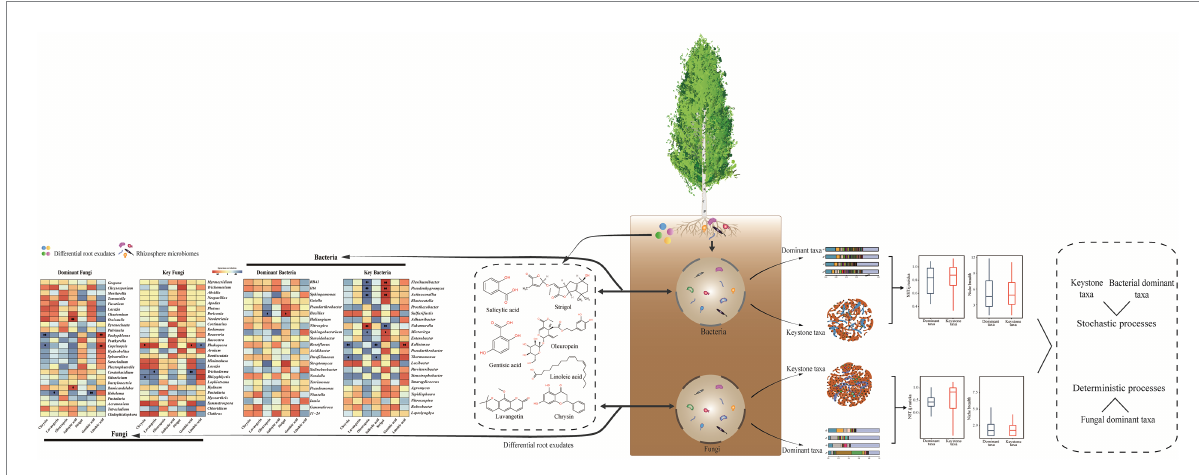
FIGURE 5 Diagram of microbial assembly process. Significance of each exudate: * p ≤ 0.05. ** p ≤